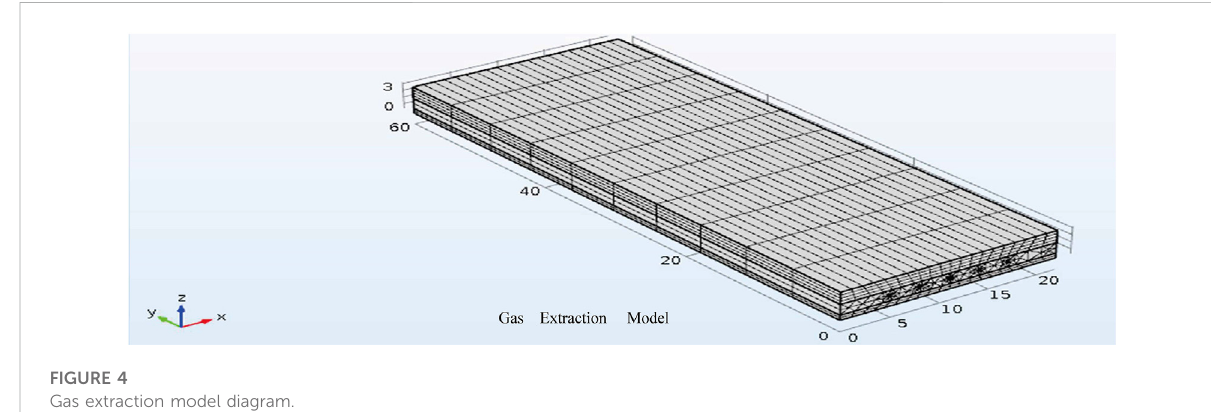
FIGURE 4 Gas extraction model diagram.